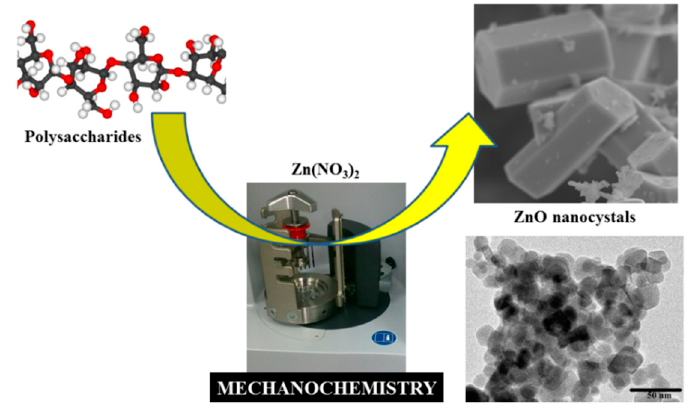
Figure 6. Mechanochemical production of designer nanomaterials from various polysaccharides.